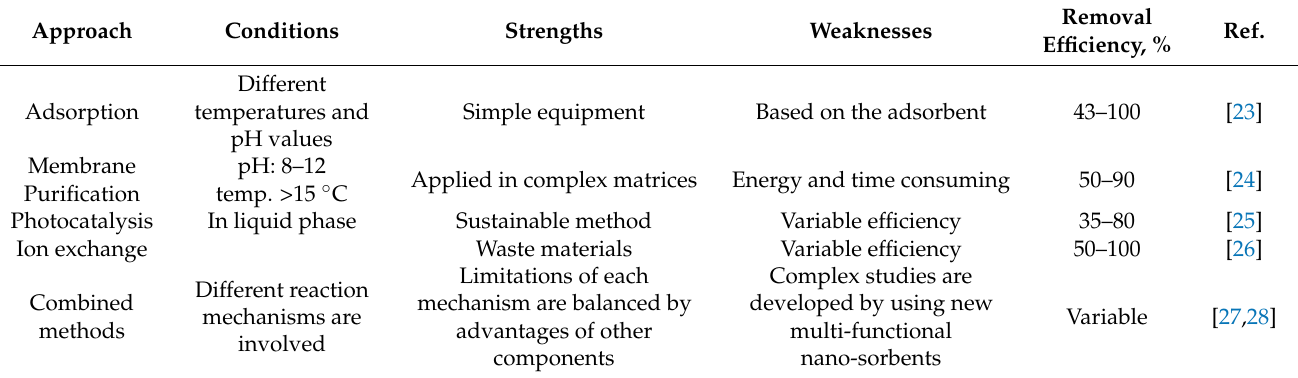
Table 1. Admitted approaches for ammonium removal from natural waters.